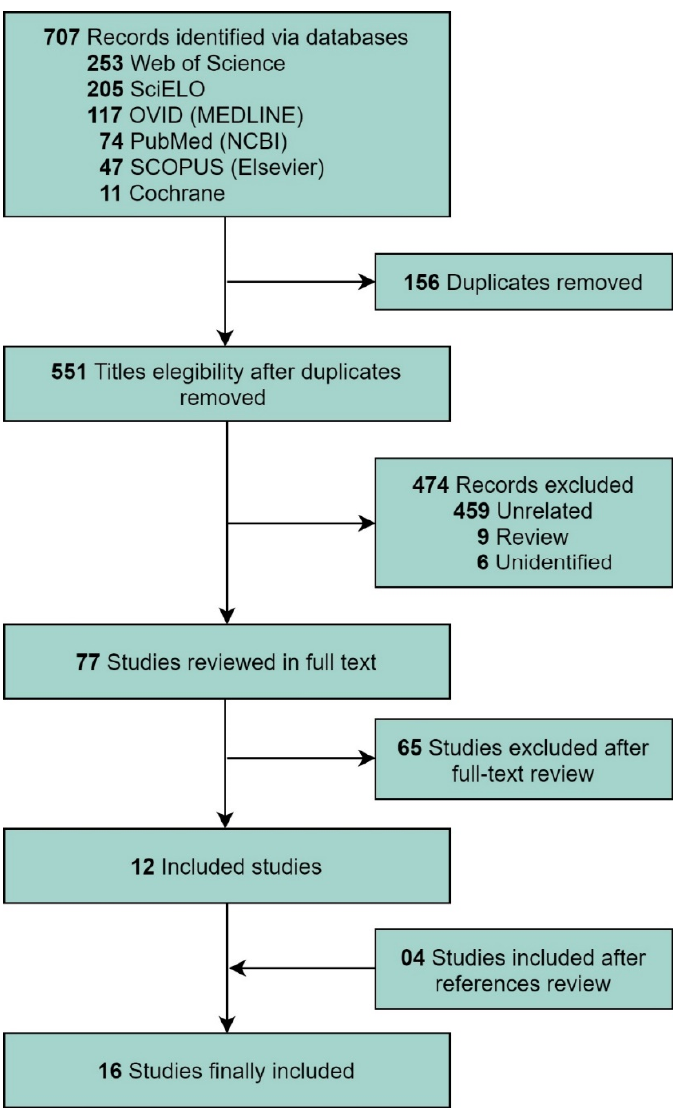
Figure 1. Flow diagram of the Preferred Reporting Items for a Systematic Review and Meta-analysis guidelines for the systematic literature search.